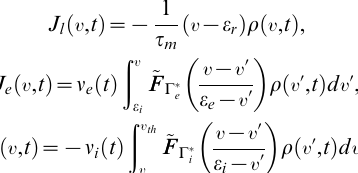
PLoS Computational Biology |